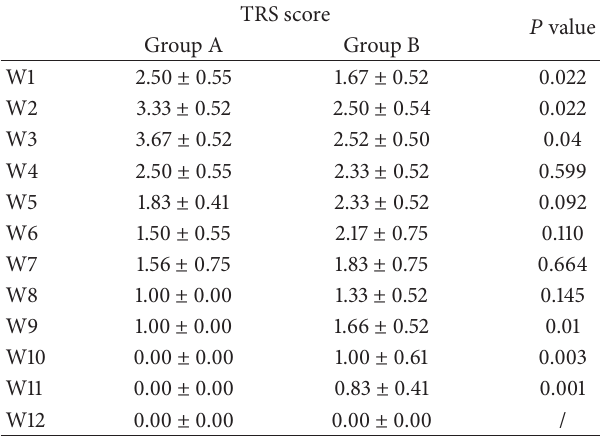
Table 2: TRS for groups A and B from week 1 to week